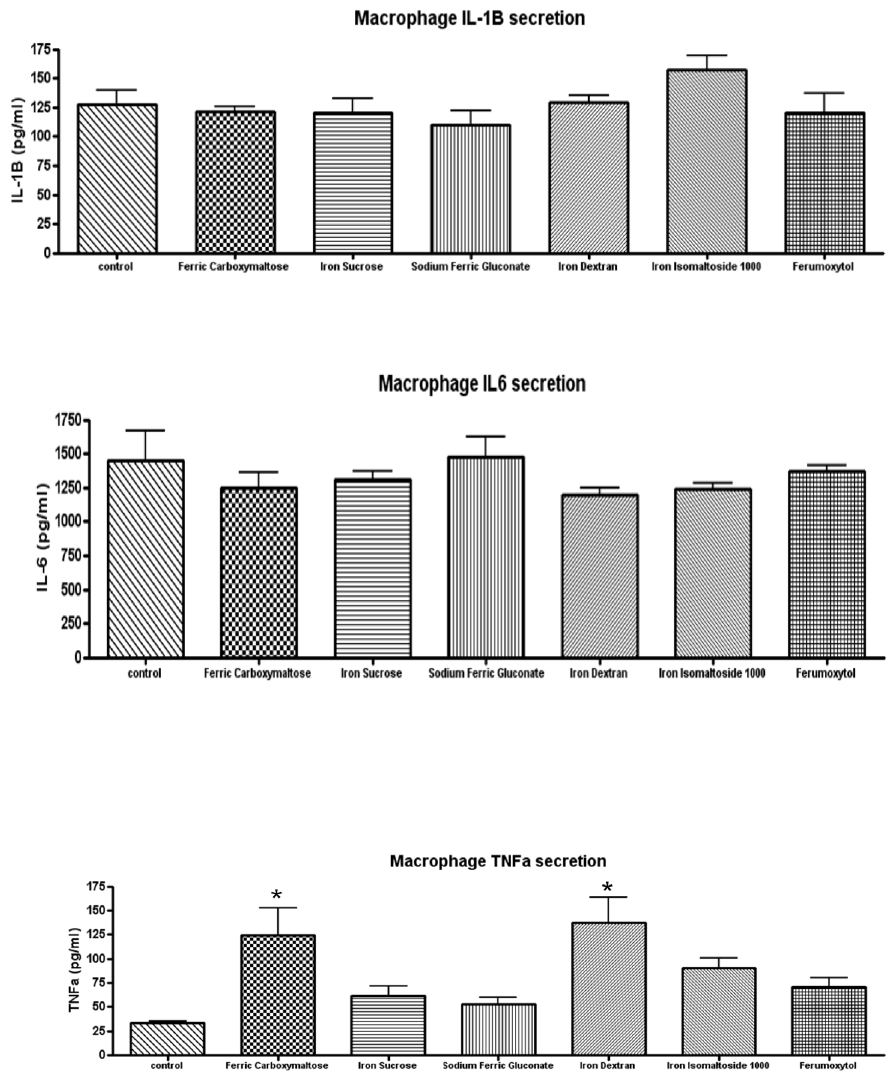
Fig 12. Cytokine secretion by primary peritoneal macrophages. Equal concentrations of 0.1 mg/ml elemental iron of the different iron compounds was added to the media. After 24 hours, the cells were rinsed and the media was changed to 2% fetal bovine serum in which the cells resided for another 24hour. The media was then collected and assayed for the different cytokines (A) Interleukin 1B, (B) Interleukin 6, (C) Tumor necrosis factor. All data shown are means ± SEM of three independent observations in separate cell culture wells. Differences were only seen with exposure to TNF α and only ferric carboxymaltose and iron dextran increases reached statistical significance * p < 0.05 compared with